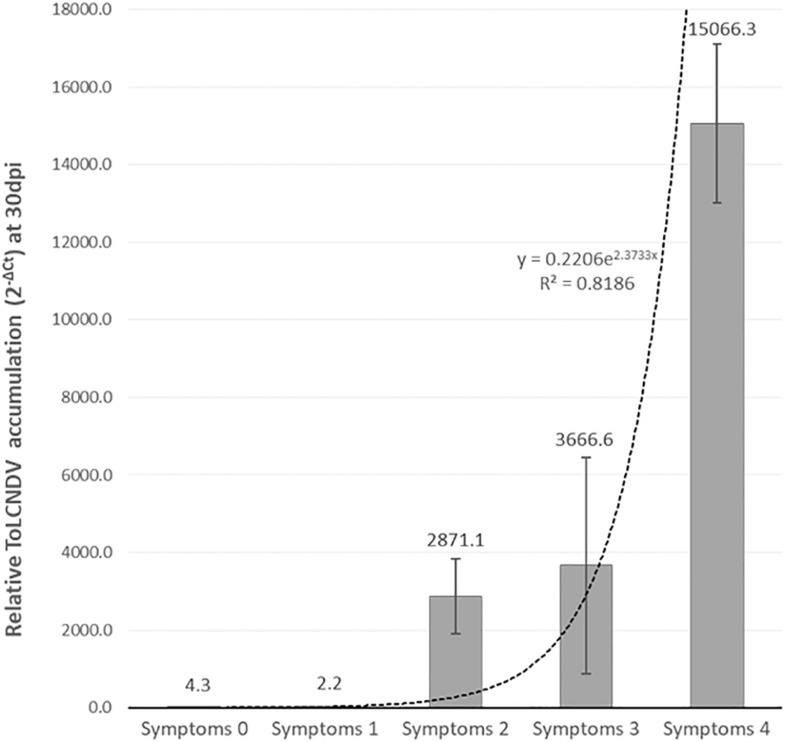
Mean of relative tomato leaf curl New Delhi virus (ToLCNDV) accumulation (calculated as 2– ΔCt) in plants within each symptomatic class in F2 (PI 419083 × PI 604506) at 30 days after mechanical inoculation. Dot line represents the exponential relationship between both variables, which was statistically significant for a confident level of α = 0.05.